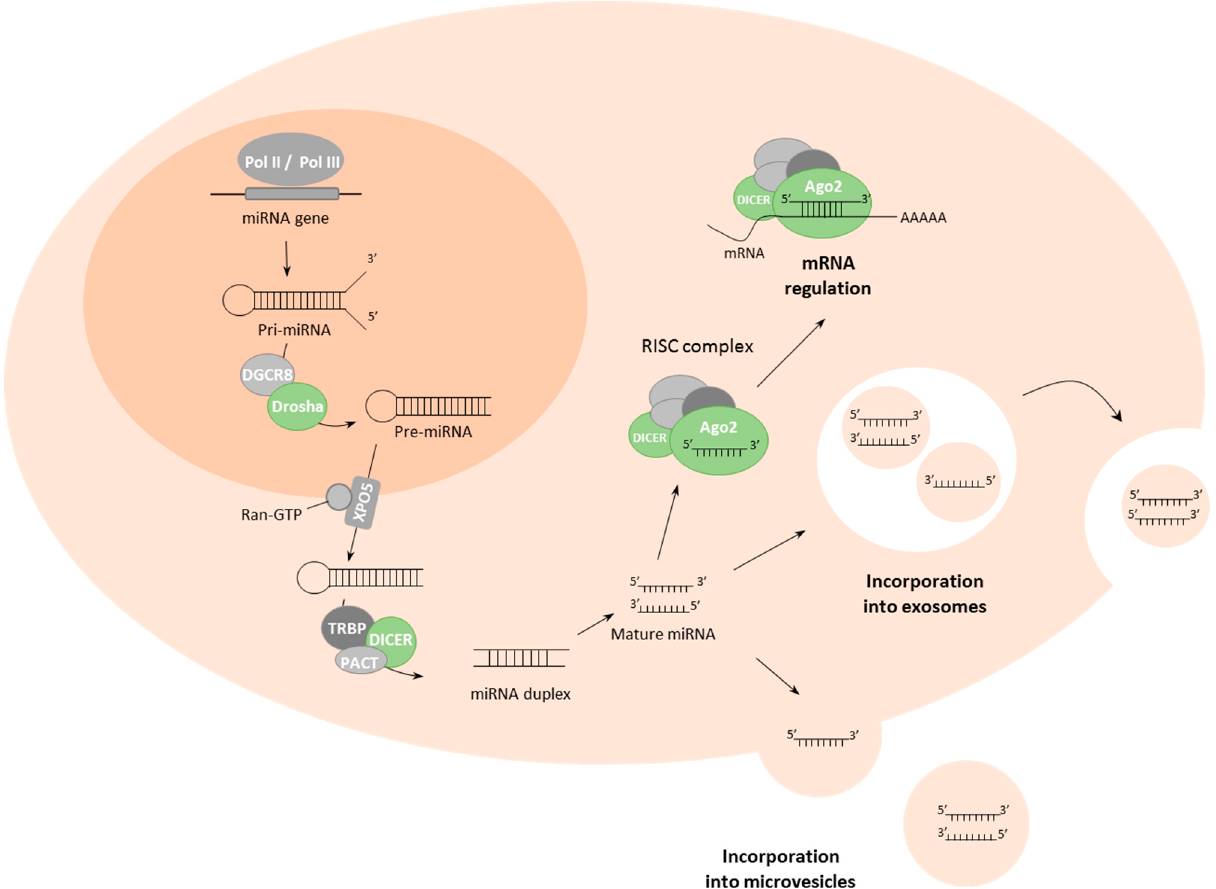
Figure 1. MiRNA biogenesis and its localization. MiRNAs are processed by polymerase II/III to form a pri-miRNA, which is processed by DGCR8 and Drosha in the nucleus. MiRNAs leave the nucleus through interaction with XPO5; in the cytoplasm, miRNAs are processed by a group of proteins, the most important being the RNAse III endonuclease Dicer, resulting in mature miRNAs. These miRNAs can be added to the RISC complex to regulate mRNA expression or can be incorporated into extracellular vesicles (exosomes and microvesicles) to reach other cells in the tumour microenvironment or cells in the premetastatic niche. Pol II / Pol III, polymerase II and III; DGCR8, DiGeorge syndrome critical region 8; XPO5, exportin-5; TRBP, HIV TAR RNA-binding protein; PACT, protein activator of PKR; RISC complex, RNA-induced silencing complex; Ago2, Argonaute 2; miRNA, microRNA; mRNA, messenger RNA.